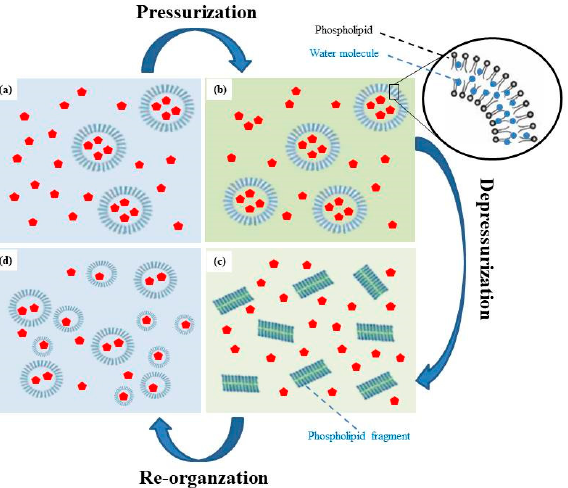
Figure 6. The mechanism of liposome formation by the HPP method ( a ) Injection ethanol and phospho- lipids; ( b ) In pressurization processing; ( c ) During decompression; ( d ) In re-organization